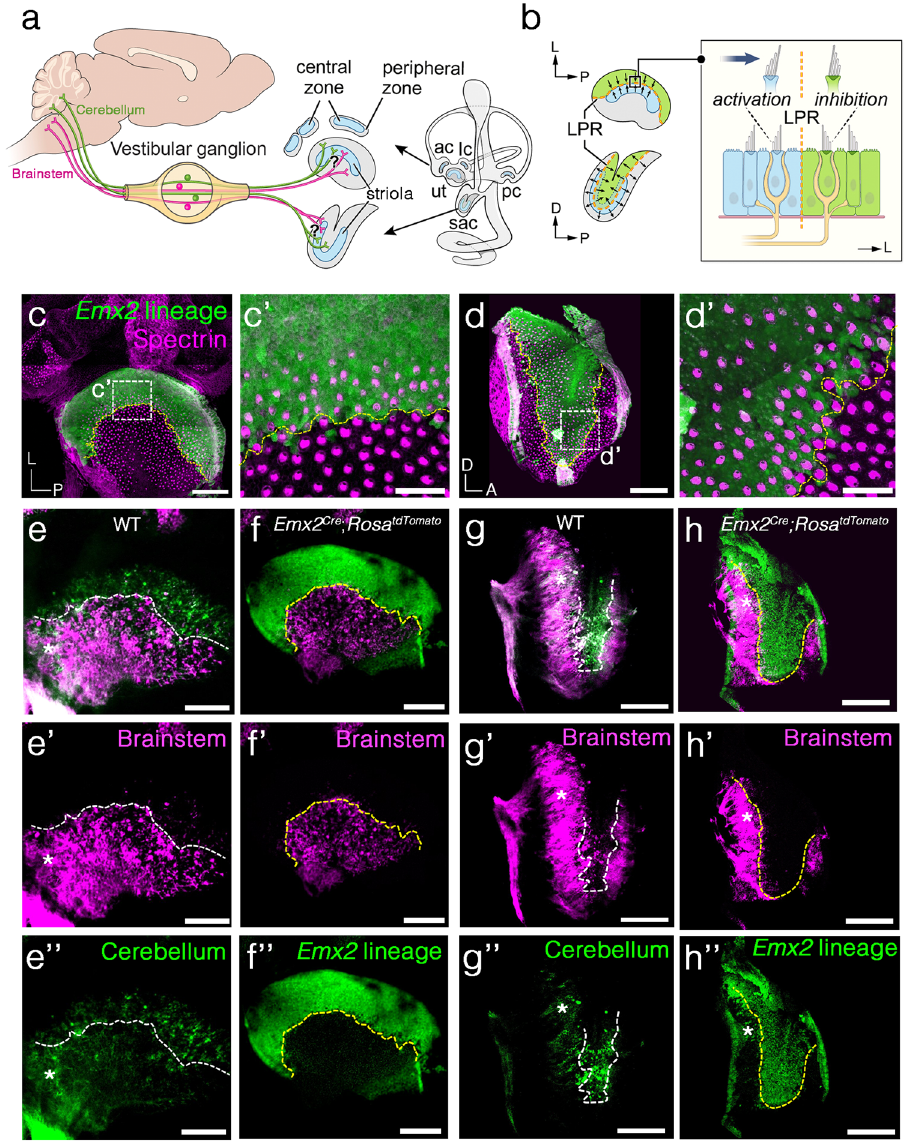
Fig. 1 | The afferent neuronal innervation pattern is segregated across the LPR in the mouse maculae. a Schematic of the segregated neuronal innervation pat- tern in maculae but the location of the segregation border is unclear. b Schematic illustrating the border of Emx2 expression domain (green) demarcates the LPR in maculae. A directional stimulus (arrow in inset) across the LPR simultaneously activatesandinhibitstwodifferentgroupsofHCs. c , d Emx2 lineagedomain(green) intheutricle( c , c ’ , n =2)andsaccule( d , d ’ , n =2)of Emx2 cre/+ ;Rosa tdTomato innerears, whichencompassesHCswithopposite hairbundle orientationfromtherestofthe macula based on anti- β spectrin staining (magenta). The location of the tallest rod of the bundle, the kinocilium, is devoid of anti- β spectrin staining 54 . The border of thelineagedomaindemarcatestheLPR(yellowdottedline). e – h ” Neuronaltracing using NeuroVue® Red (magenta)- and NeuroVue® Maroon (green)-soaked fi lter papers inserted into the brainstem and cerebellum of hemi-sectioned heads